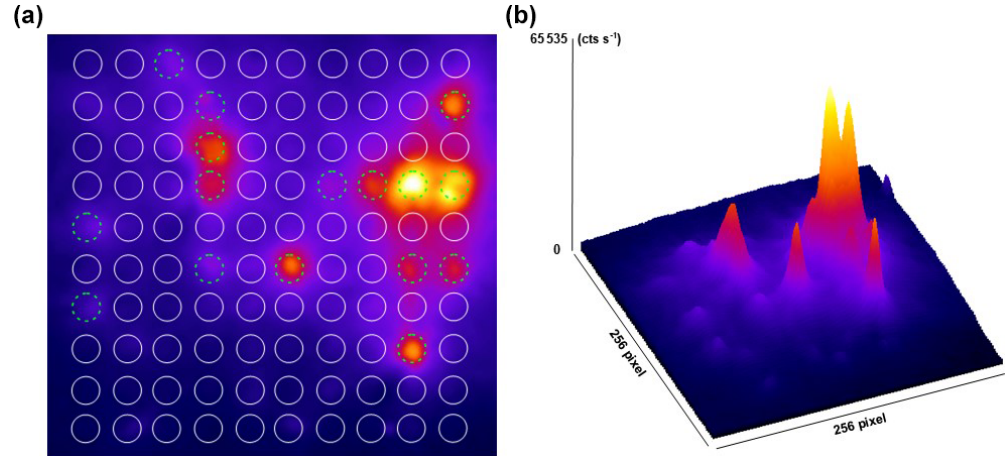
Figure 10. Coloured EMCCD image obtained from the natural IRSL signal of 100 F grains of RIN2. The grains were placed on a Risø single grain disc with a 10 × 10 grid of holes (300µm in diameter). (a) Holes containing F grains emitting luminescence are presented with dashed green circles, while those without emission are shown in white. (b) The 3D surface plot emphasises that some grains inherit very bright signals, while others are rather dim.